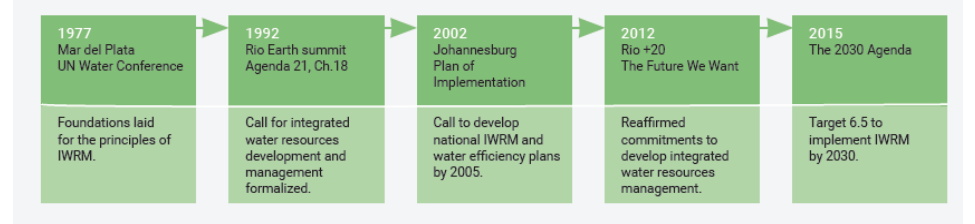
Figure 2. Key global agreements on implementing integrated approaches to water resources management [36].